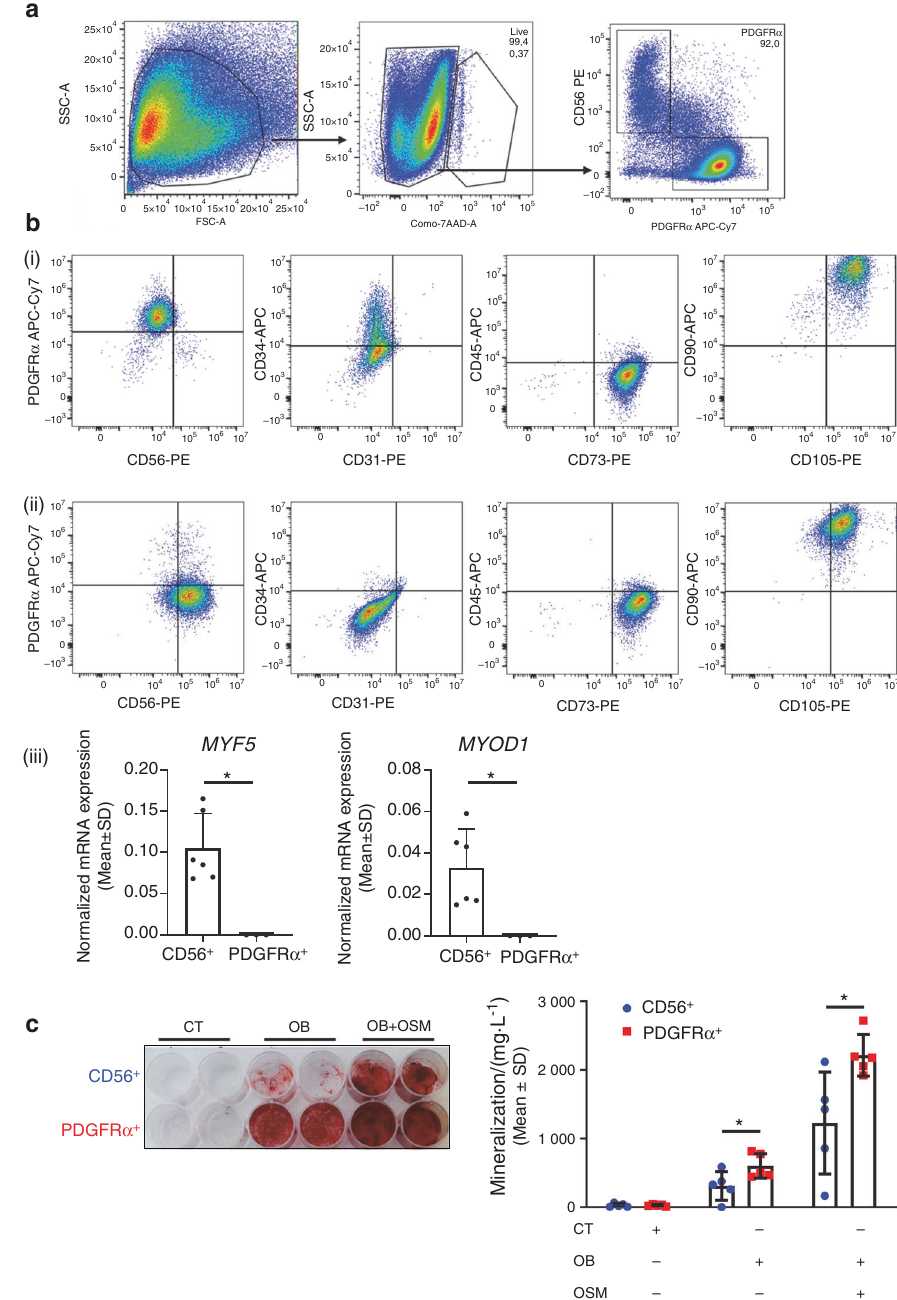
Fig. 6 Human PDGFR α + cells isolated from muscles surrounding NHOs support in vitro bone formation. a Flow cytometry gating strategy of PDGFR α + and CD56 + cell subpopulations isolated from muscle surrounding NHOs. b Representative surface marker characterization by fl ow cytometry: CD56, PDGFR α , CD31, CD34, CD45, CD73, CD90, and CD105, ( i ) CD56 + population, ( ii ) PDGFR α + population, ( iii ) Normalized mRNA expression of MYF5 and MYOD1 by qRT-PCR expressed as the mean ± SD (CD56 + n = 6; PDGFR α + n = 3). c In vitro osteoblastic differentiation assay seeded with CD56 + or PDGFR α + cells isolated from muscles surrounding human NHOs. (i ) All cells were cultured in control medium (CT) or osteogenic medium alone (OB) or were supplemented with human OSM (100 ng·mL − 1 ) (OB + OSM) for 14 days followed by Alizarin Red S staining. c ( ii ) Quanti fi cation of calcium mineralization expressed as the mean ± SD ( n = 5). * P < 0.05, two-sided nonparametric Mann – Whitney U